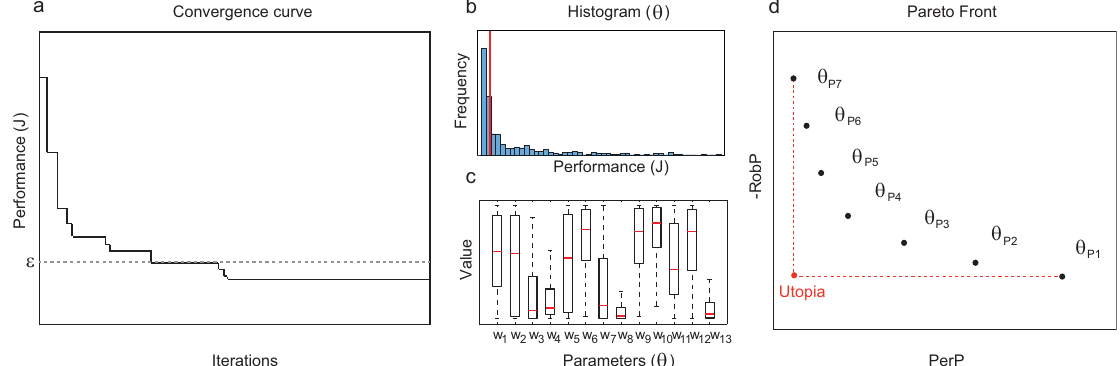
Figure 1. Details of the method. ( a ) Convergence curve of a single run of the optimization algorithm; solutions with performance values under the threshold (cid:101) are collected for further analysis. ( b ) Global performance of structure θ : frequency distribution of performance value J (median highlighted in red). ( c ) Robustness of topology θ : interquartile range (IQRs) for each of the active parameters. ( d ) Pareto front of topologies with optimal trade-off of global performance and